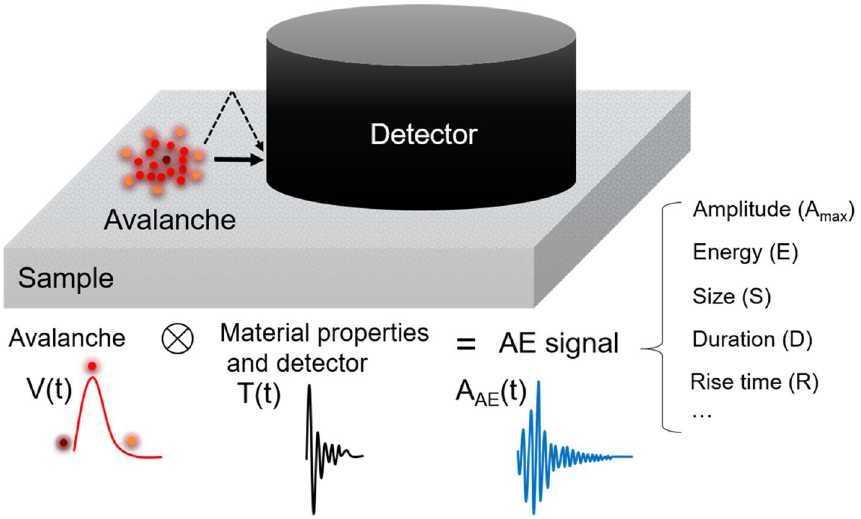
Figure 1. Schematic representation of the composition of an avalanche signal in acoustic emission experiments. The size of the sample and the detector is some 5 mm, the detector covers often a large part of the sample. During local switching, an avalanche with V ( t ) emits a strain signal (i.e. the source function) which propagates through the sample and is eventually measured by the detector. During the propagation, the signal generates the ringing of the sample and is modified by elastic wave reflections on surfaces, scattering on lattice imperfections. The profile of a source delta function would generate T ( t ) , the so-called transfer function. The measured AE profile A AE ( t ) is described in this paper as the convolution of the source function with the transfer